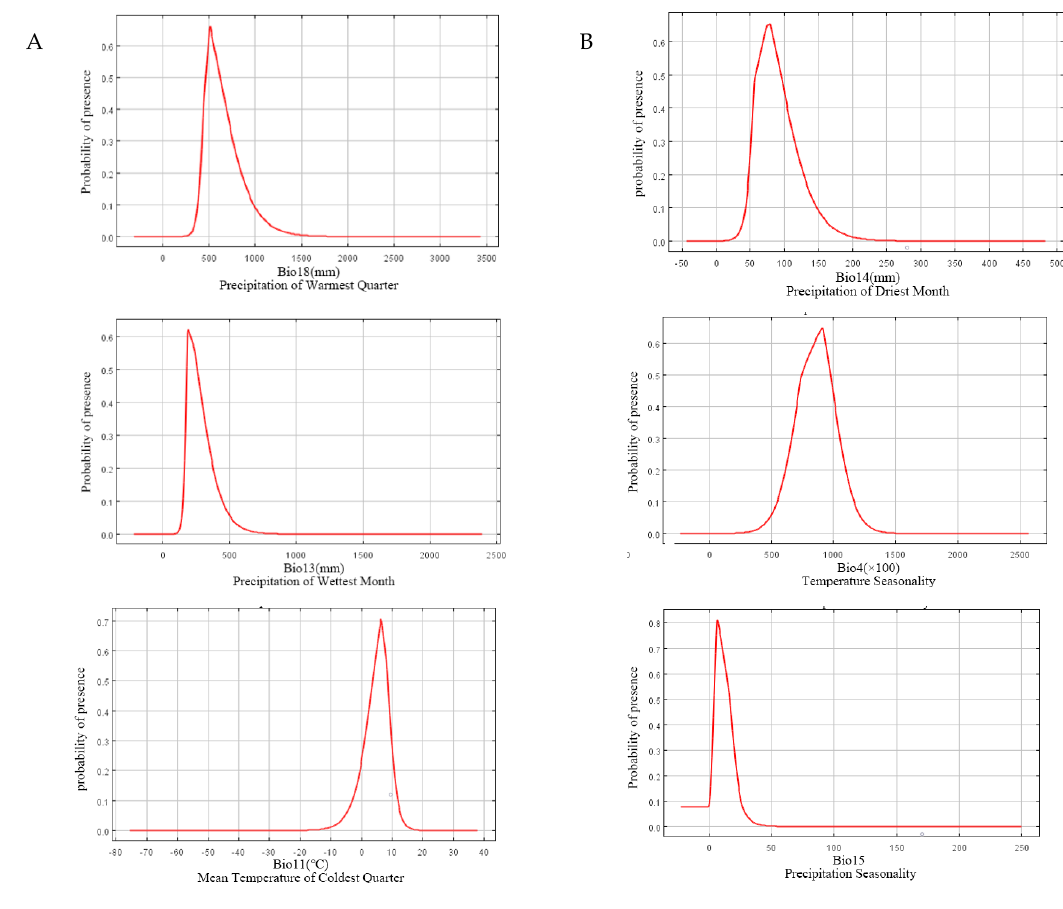
Figure 3. Response curves for important environmental predictors in the species distribution model for Liriodendron chinense ( A ) and Liriodendron tulipifera ( B ).